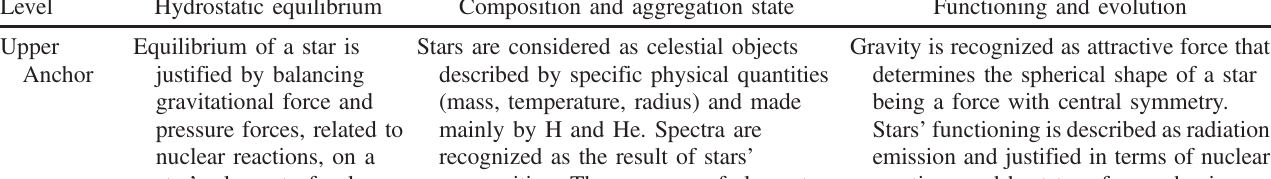
TABLE VII. Final LP about SSE (LP3). Lower anchor to level 3 are as in LP1 (Table II) and LP2 (Table V). Level Hydrostatic equilibrium Composition and aggregation state Functioning and evolution Upper Equilibrium of a star is Anchor justified by balancing gravitational force and pressure forces, related to nuclear reactions, on a star ’ s element of